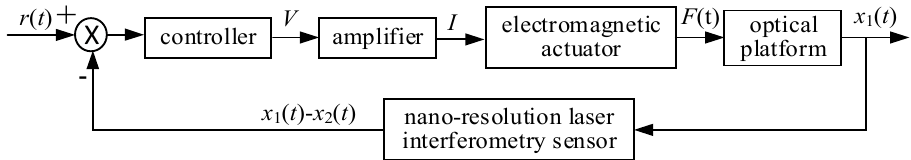
Figure 15. Control block diagram of the electromagnetic actuator.